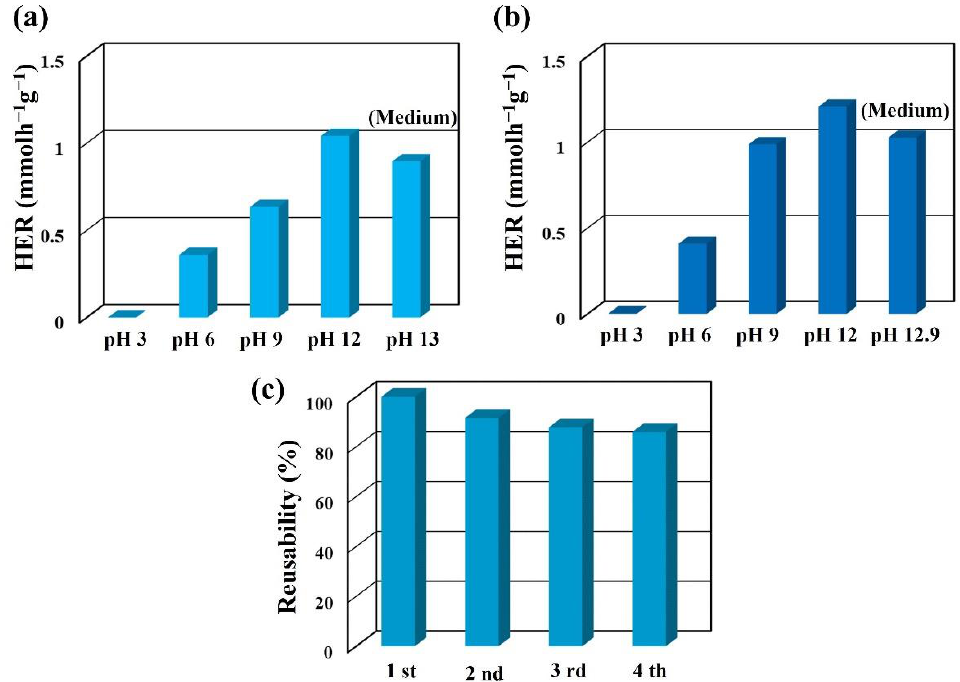
Figure 9. The average HER of Au@CdS nanocomposites at different pH values of ( a ) de-ionized water and ( b ) tap water. ( c ) Four cycles of photocatalytic tap water splitting with Au@CdS nanocomposites as hydrogen-evolving photocatalysts.